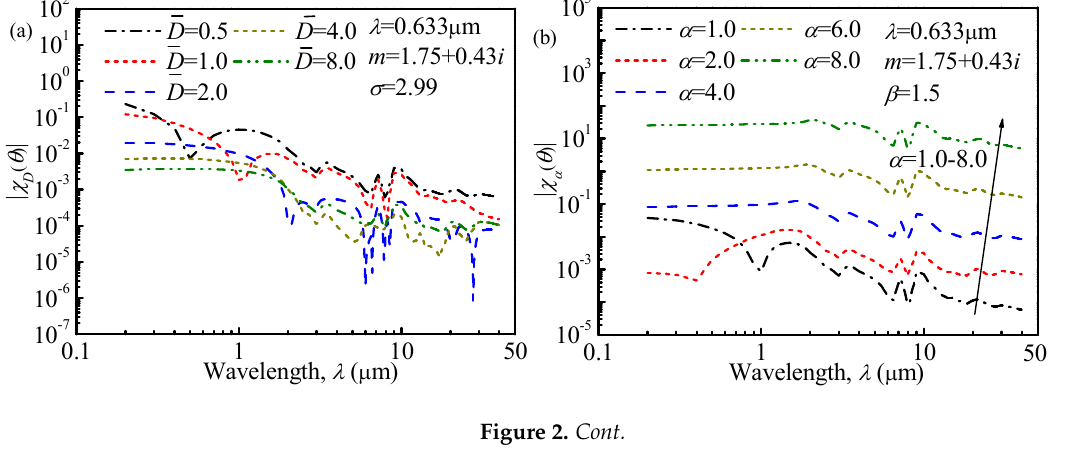
Figure 2. Sensitivity analysis of spectral transmittance signals to characteristic parameters in ASDs: ( a , c ) for L-N distribution, ( b , d ) for Gamma distribution.